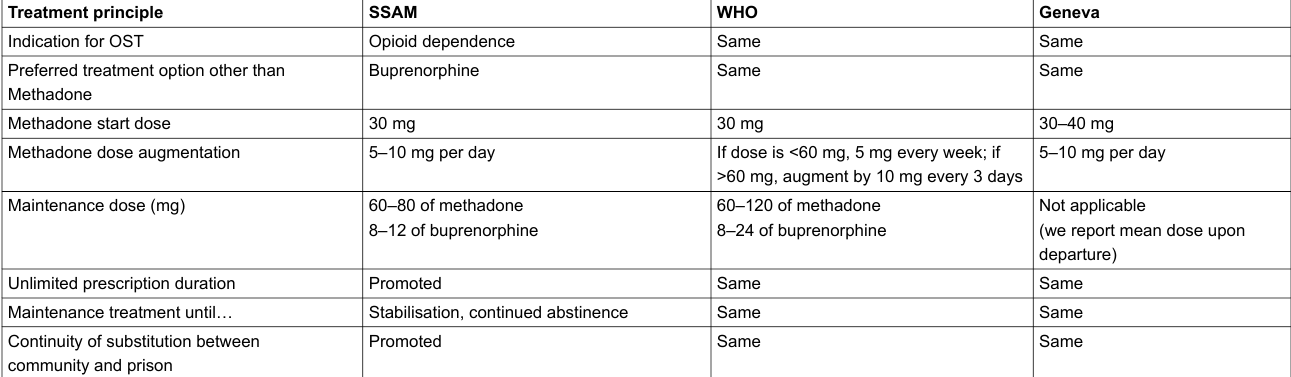
Continuity of substitution between community and